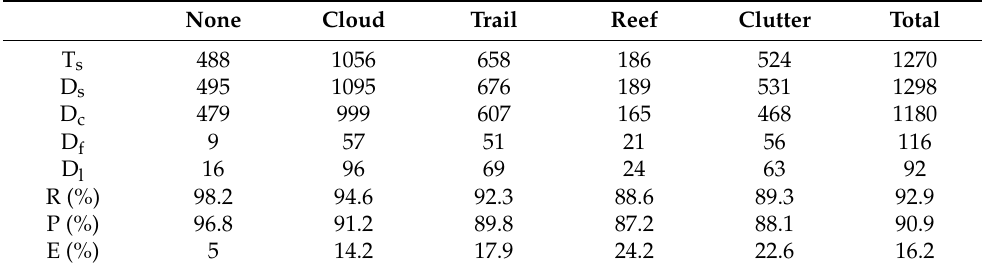
Table 2. Detection results of our method under different interferences. None Cloud Trail Reef Clutter